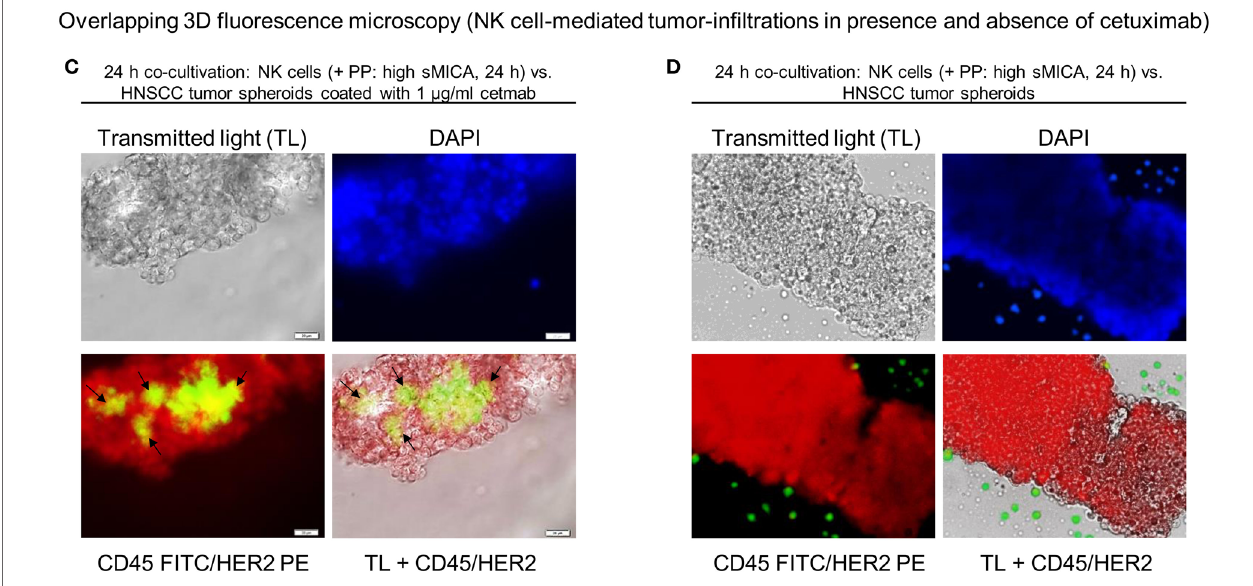
FigUre 6 | reconstitution of nK cell-dependent tumor infiltration by cetuximab . Tumor recognition and infiltration of sMICA-affected NK cells in absence or presence of cetuximab (1 μ g/ml) were analyzed by co-culturing (24 h, 37°C, 5% CO 2 ) of corresponding patient NK cells, plasma (high sMICA) and HNSCC tumor spheroids derived from HNSCC patient tumors ( n = 5). Activated NK cells were pre-incubated (24 h) with corresponding patient plasma containing high sMICA (PP: > 500 pg/ml; diluted 1:2 with X-VIVO ™ 10) and co-incubated (24 h) with primary HNSCC spheroids (time of cultivation: 11–14 days) in the presence of 1 μ g/ml cetuximab. CD45 (green) for PP-treated patient NK cells were identified by staining with FITC-conjugated mAb, whereas tumor spheroids were labeled with anti-HER2 PE-conjugated mABs (a) . Tumor-infiltrating NK cells were illustrated by overlay plots (CFM). Exactly the same orientation of CD45 + NK cells (green) and HER2 + tumor spheroids (red) showed a positive, overlapping signal in yellow [see black arrows (B) ] for ADCC-related effector-target cell interactions, whereas single positive, HNSCC cells (CD45 − /HER2 + ) are shown as red signals and single positive NK cells are depicted by green signals in the corresponding photographs (a) . 3D fluorescence microscopy visualized tumor-infiltrating patient NK cells (green-yellow areas) in corresponding HNSCC tumor spheroids in the presence (c) and absence (D) of 1 μ g/ml cetuximab. DAPI [blue signals (a,c,D) ] was used to stain DNA from methanol-fixed effector and target cells for analyses of the nuclear